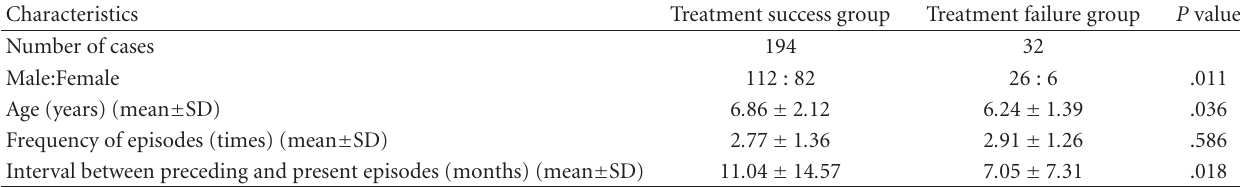
Table 3: Characteristics of children with treatment success and treatment